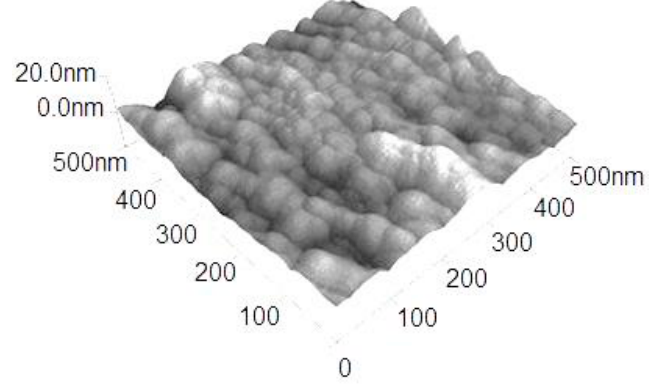
Figure 2. Topography (AFM image) of the WC/C coating.